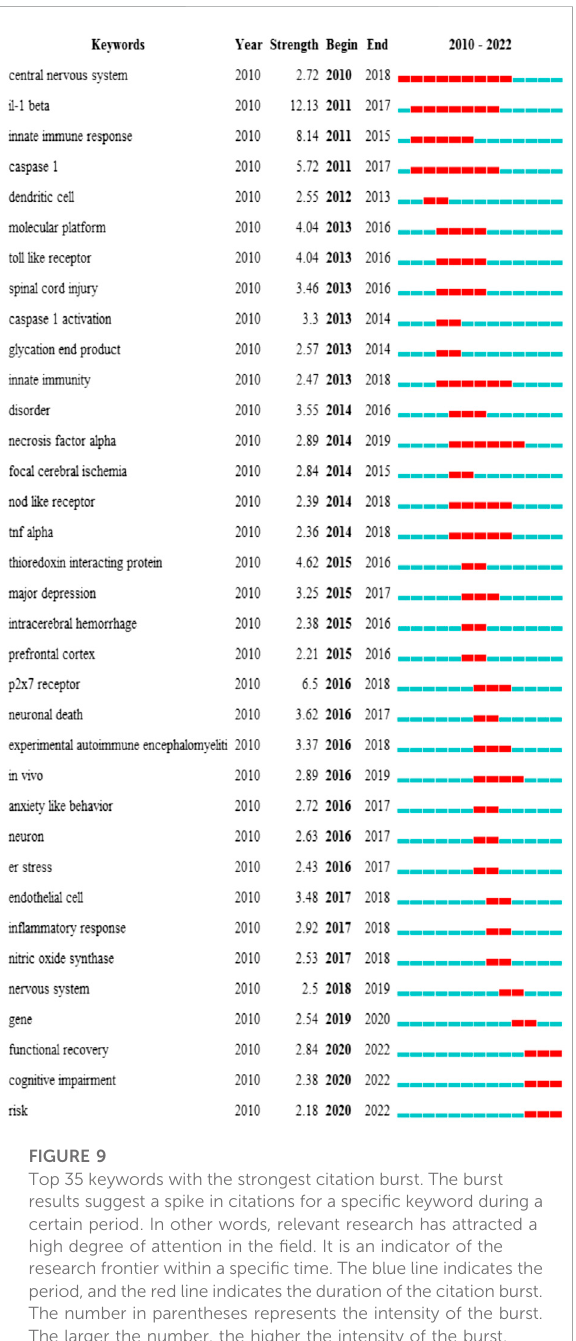
FIGURE 9 Top 35 keywords with the strongest citation burst. The burst results suggest a spike in citations for a speci fi c keyword during a certain period. In other words, relevant research has attracted a high degree of attention in the fi eld. It is an indicator of the research frontier within a speci fi c time. The blue line indicates the period, and the red line indicates the duration of the citation burst. The number in parentheses represents the intensity of the burst. The larger the number, the higher the intensity of the